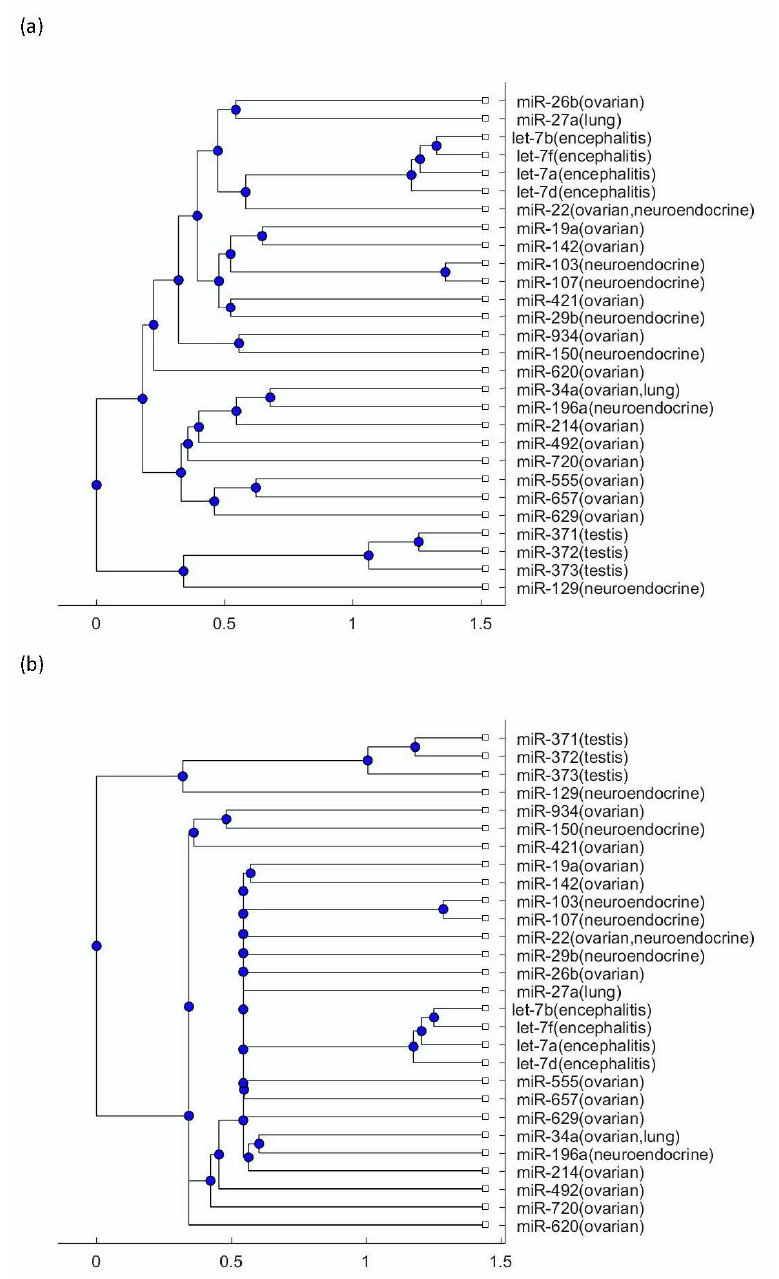
Figure 3. ( a ) The phylogenetic tree of miRNAs shown in Table 1 based on the alignment-score distance and the average method. ( b ) The phylogenetic tree of miRNAs shown in Table 1 based on the alignment-score distance and the median